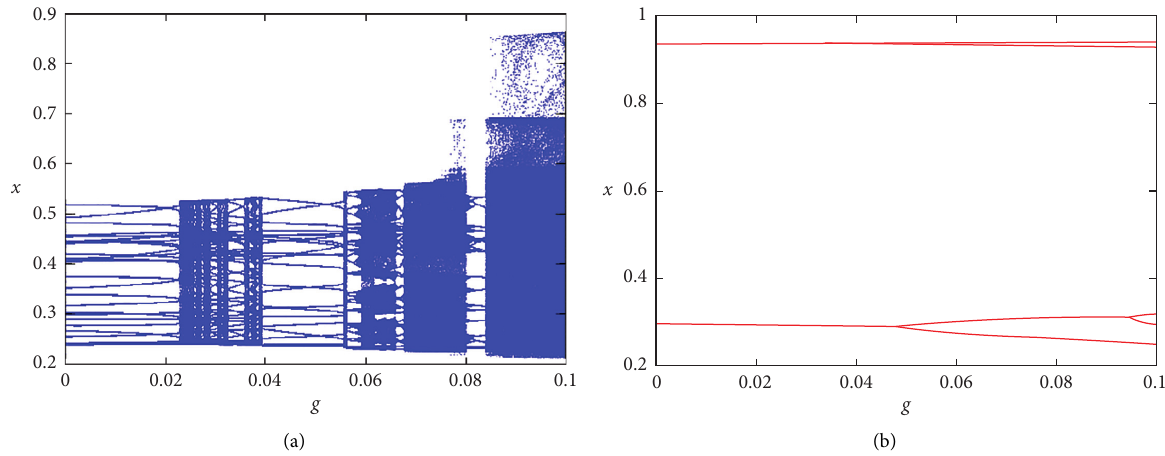
Figure 10: Bifurcation diagram and its corresponding Lyapunov exponent of nonlinear chemical reaction with ω � 0.0481, Ω � 80 ω , α � 0.0413, f � 0.002, and β � 0.0667. Bifurcation diagrams and its corresponding Lyapunov exponent are obtained by scanning the pa- rameter g upwards (a) and downwards